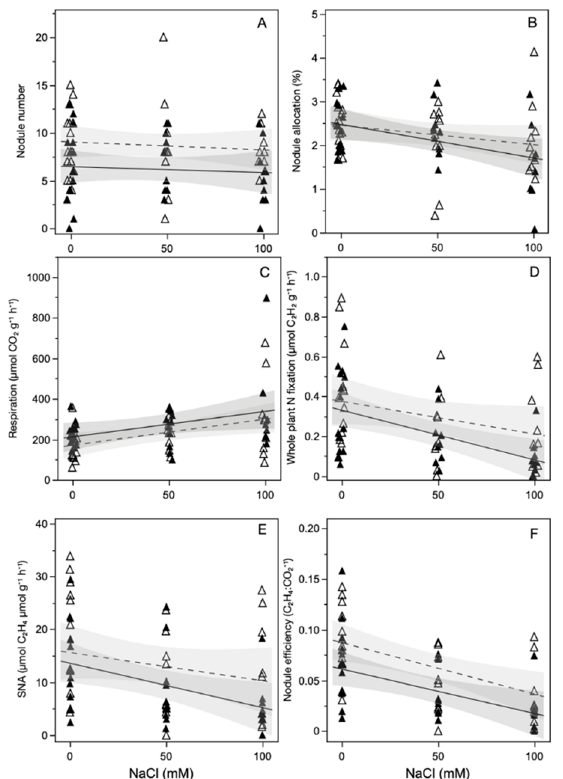
Figure 2. Effect of salt exposure on: ( A ) nodule number; ( B ) total plant biomass allocated to nodules; ( C ) nodule respiration; ( D ) nitrogenase activity relative to whole plant mass; ( E ) specific nodule activity; ( F ) the efficiency of nitrogenase activity, for plants that were inoculated with both Frankia and ECMF (closed symbols) or Frankia (open symbols). Table 2. p values from least squares models of the effect of ECMF and salt exposure on nodule number, biomass allocation to nodules, nodule respiration, specific nodule activity (SNA), and nod- ule efficiency.